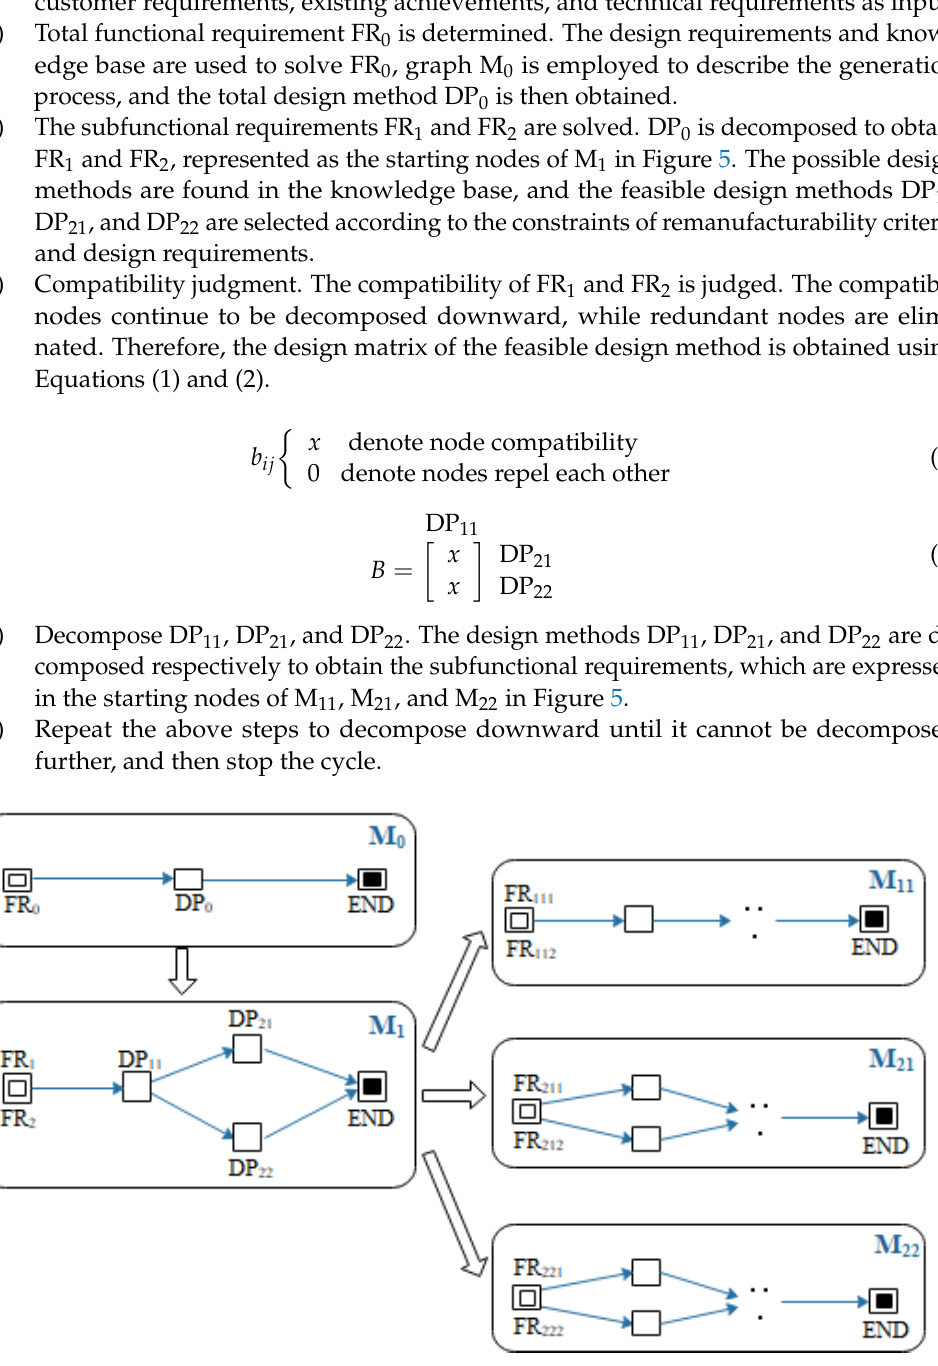
Figure 5. The scheme generation process based on tree topological mapping.